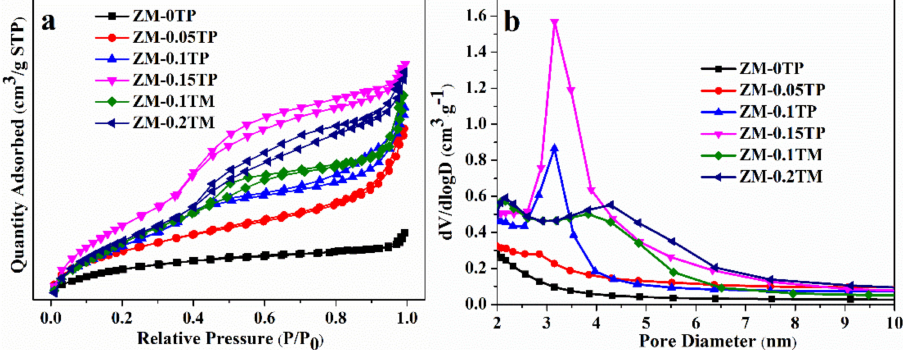
Figure 4. Porous properties of the zeolites.